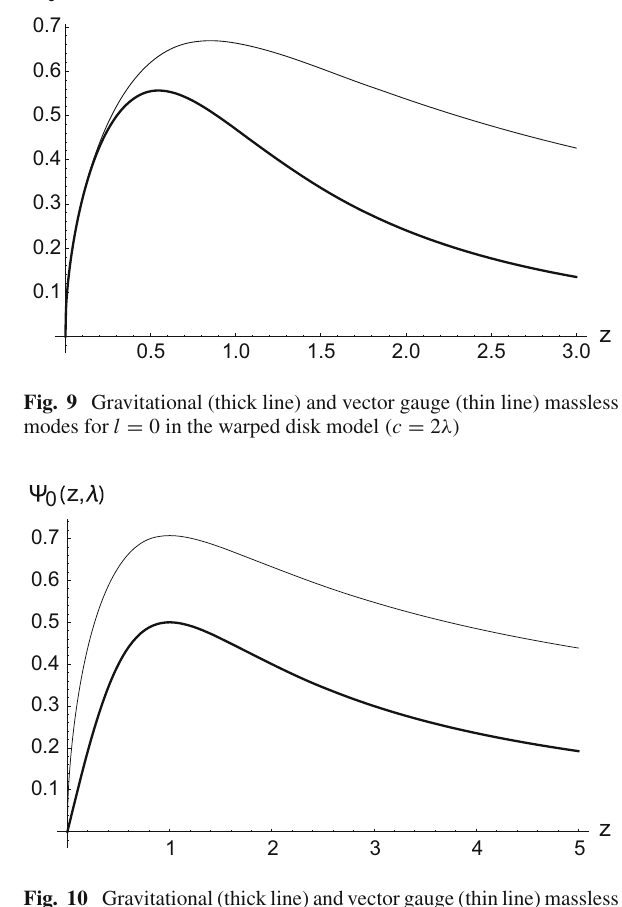
Fig. 10 Gravitational (thick line) and vector gauge (thin line) massless modes for l = 0 in the exotic string model ( c = 2